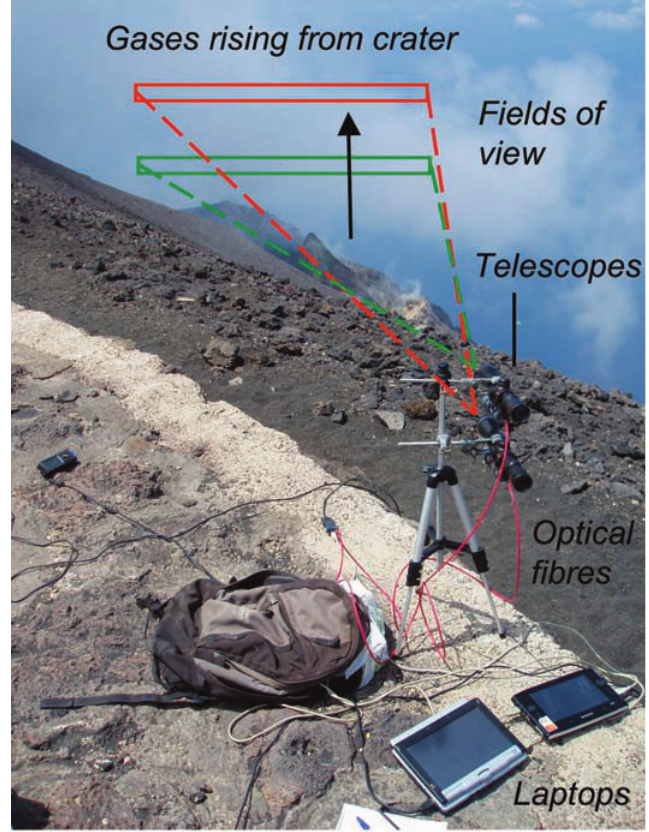
Figure 3. Configuration of the wide-angle field-of-view DOAS approach to determine high-time-resolution volcanic SO fluxes, as applied to the 2 rising plume from Stromboli volcano. The orientation of the telescopes, and their quasi-rectangular fields of view are shown, in addition to the fiber connections to the miniature UV spectrometers and the controlling laptops. Note that the spectrometers themselves are concealed within the shade of the